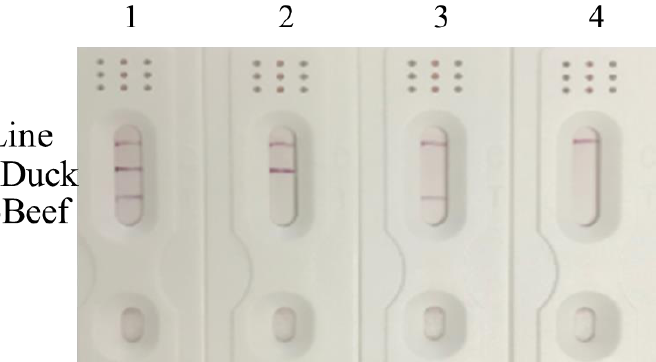
Figure 3. Performance of the RPA-MLFD assay. Lane 1: beef + duck; Lane 2: duck; Lane 3: beef; Lane 4: negative control.